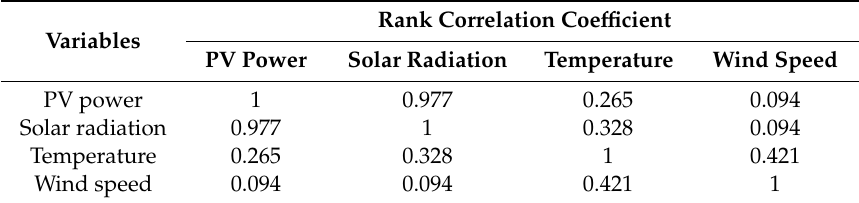
Table 2. Kendall rank correlation coe ffi